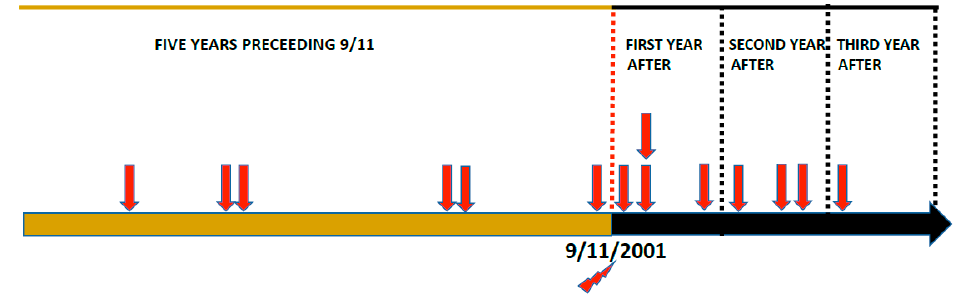
Figure 1. Timeline of aircraft-assisted pilot suicides five years before and three years after 11 September 2001. Red arrows indicate aircraft assisted suicides.